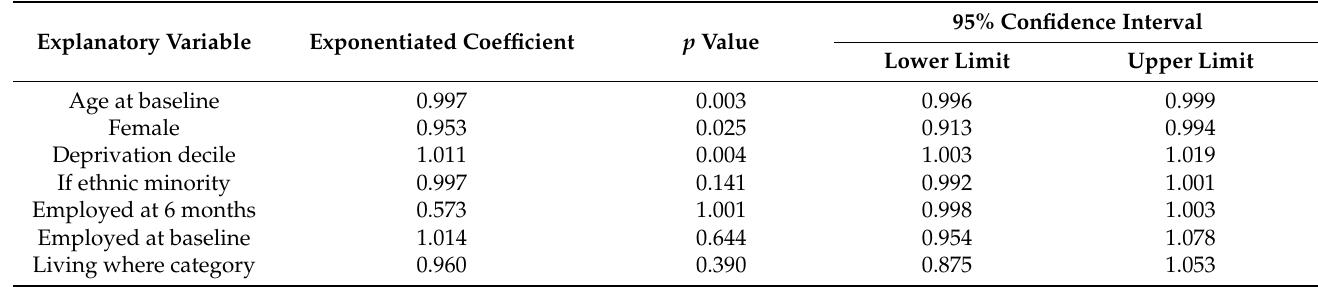
Table 5. Effect of participant characteristics (from modelling, before selection).